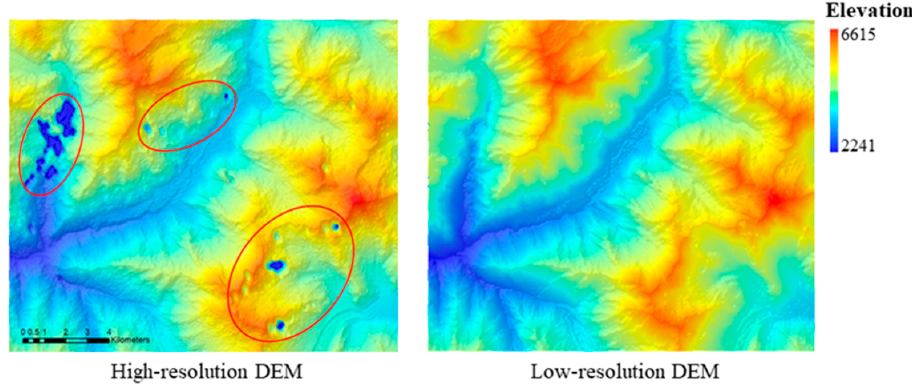
Figure 1. Comparison of a high-resolution DEM containing missing parts and the corresponding low-resolution DEM.